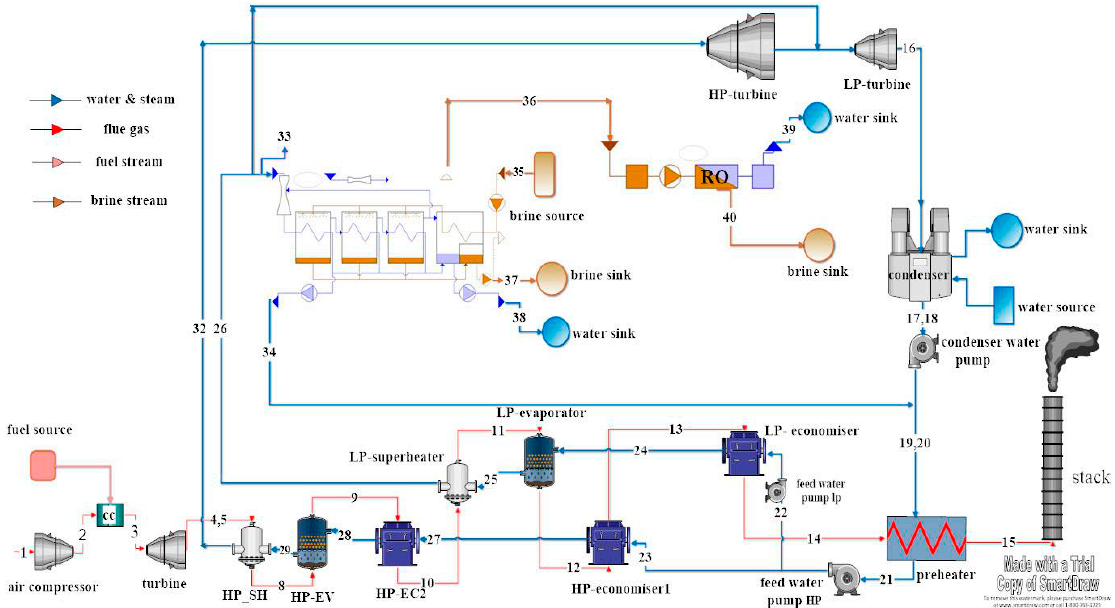
Figure 2. Schematic diagram of the new integrated combined cycle power plant (CCPP) with multi-effect distillation (MED) and reverse osmosis (RO) desalination system. LP, low-pressure; HP,